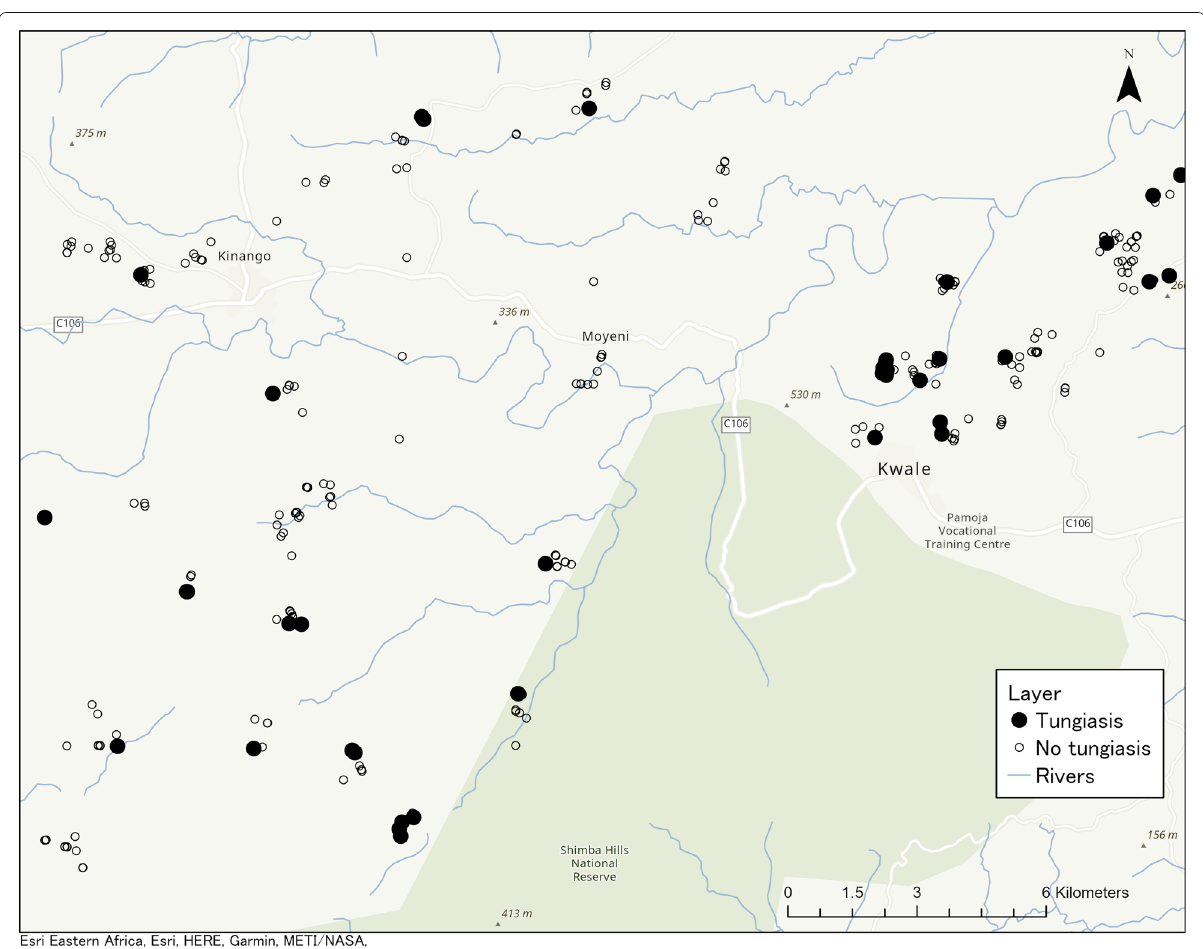
Fig. 2 Locations of surveyed households and Shimba Hills Wildlife Reserve